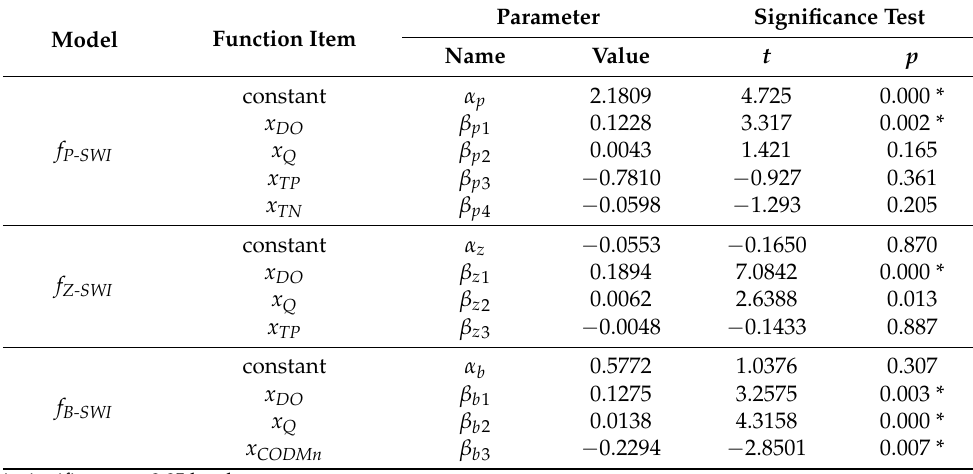
Table 3. Structure and parameter settings of MEL